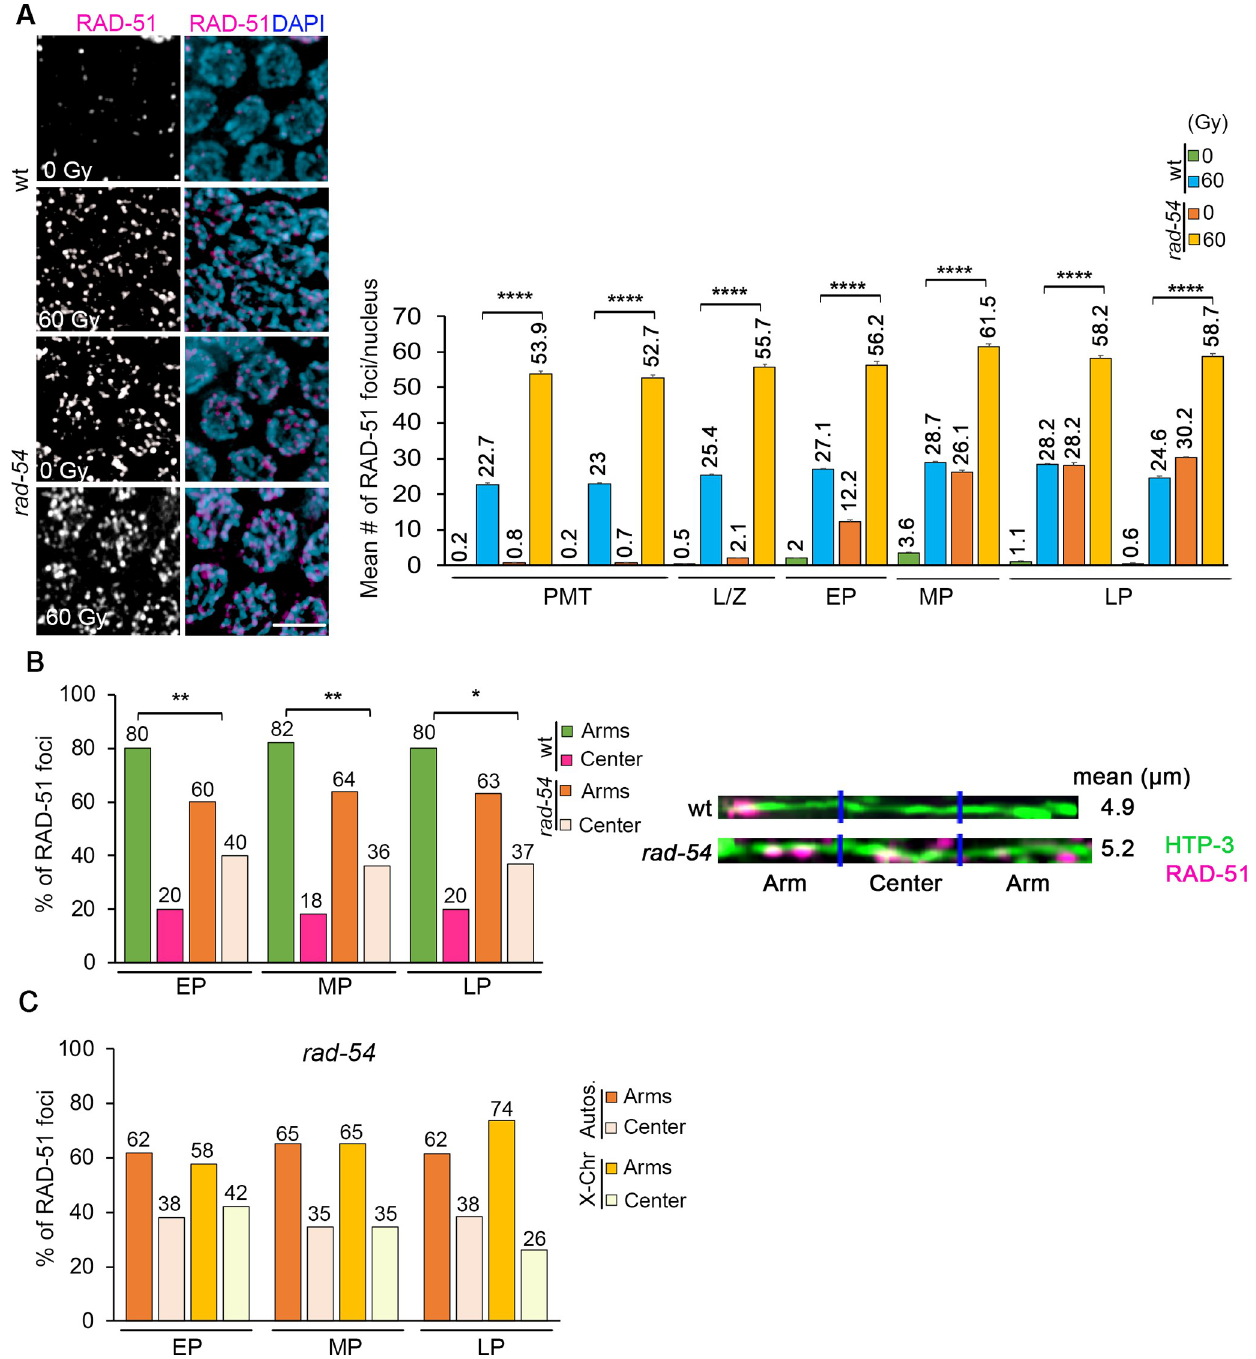
Fig 2. Blocked RAD-51 nucleofilament turnover results in unbiased distribution. (A) Left, high-resolution images of mid-pachytene nuclei (zone 5) immunostained for RAD-51 (magenta) and co-stained with DAPI (blue). Scale bar, 2 μ m. Right, histogram shows the mean number of RAD-51 foci/nucleus (y-axis) scored along each zone in the germline (x-axis) of the indicated genotypes and conditions. At least 6 gonads were scored per genotype. Mean number of RAD-51 foci is indicated above each bar graph. Error bars represent SEM from technical repeats for each of two biological replicates. ���� p < 0.0001. Comparisons that scored significant between wild-type + 60 Gy and rad-54 + 60 Gy are indicated. (B) Left, histogram shows the distribution of RAD-51 foci at the center versus the arms of the chromosomes throughout pachytene (early to late) in rad-54 mutants compared to wild-type animals + and–IR (60 Gy). RAD-51 foci are more evenly distributed throughout the chromosomes in rad-54 mutants compared to wild-type. Percentages are indicated above each bar graph. � p < 0.05, �� p < 0.01. Right, representative images of linearized chromosomes from rad-54 and wild-type worms co-stained with anti-HTP-3 (green), and anti-RAD-51 (magenta). A minimum of 50 chromosomes per condition were linearized. Mean length ( μ m) of the linearized